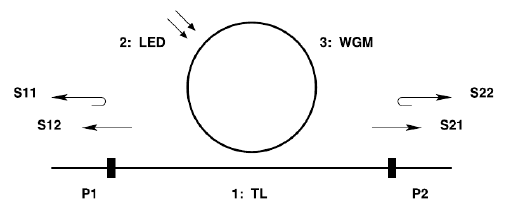
Figure 2: Schematic of a microwave WGM resonator